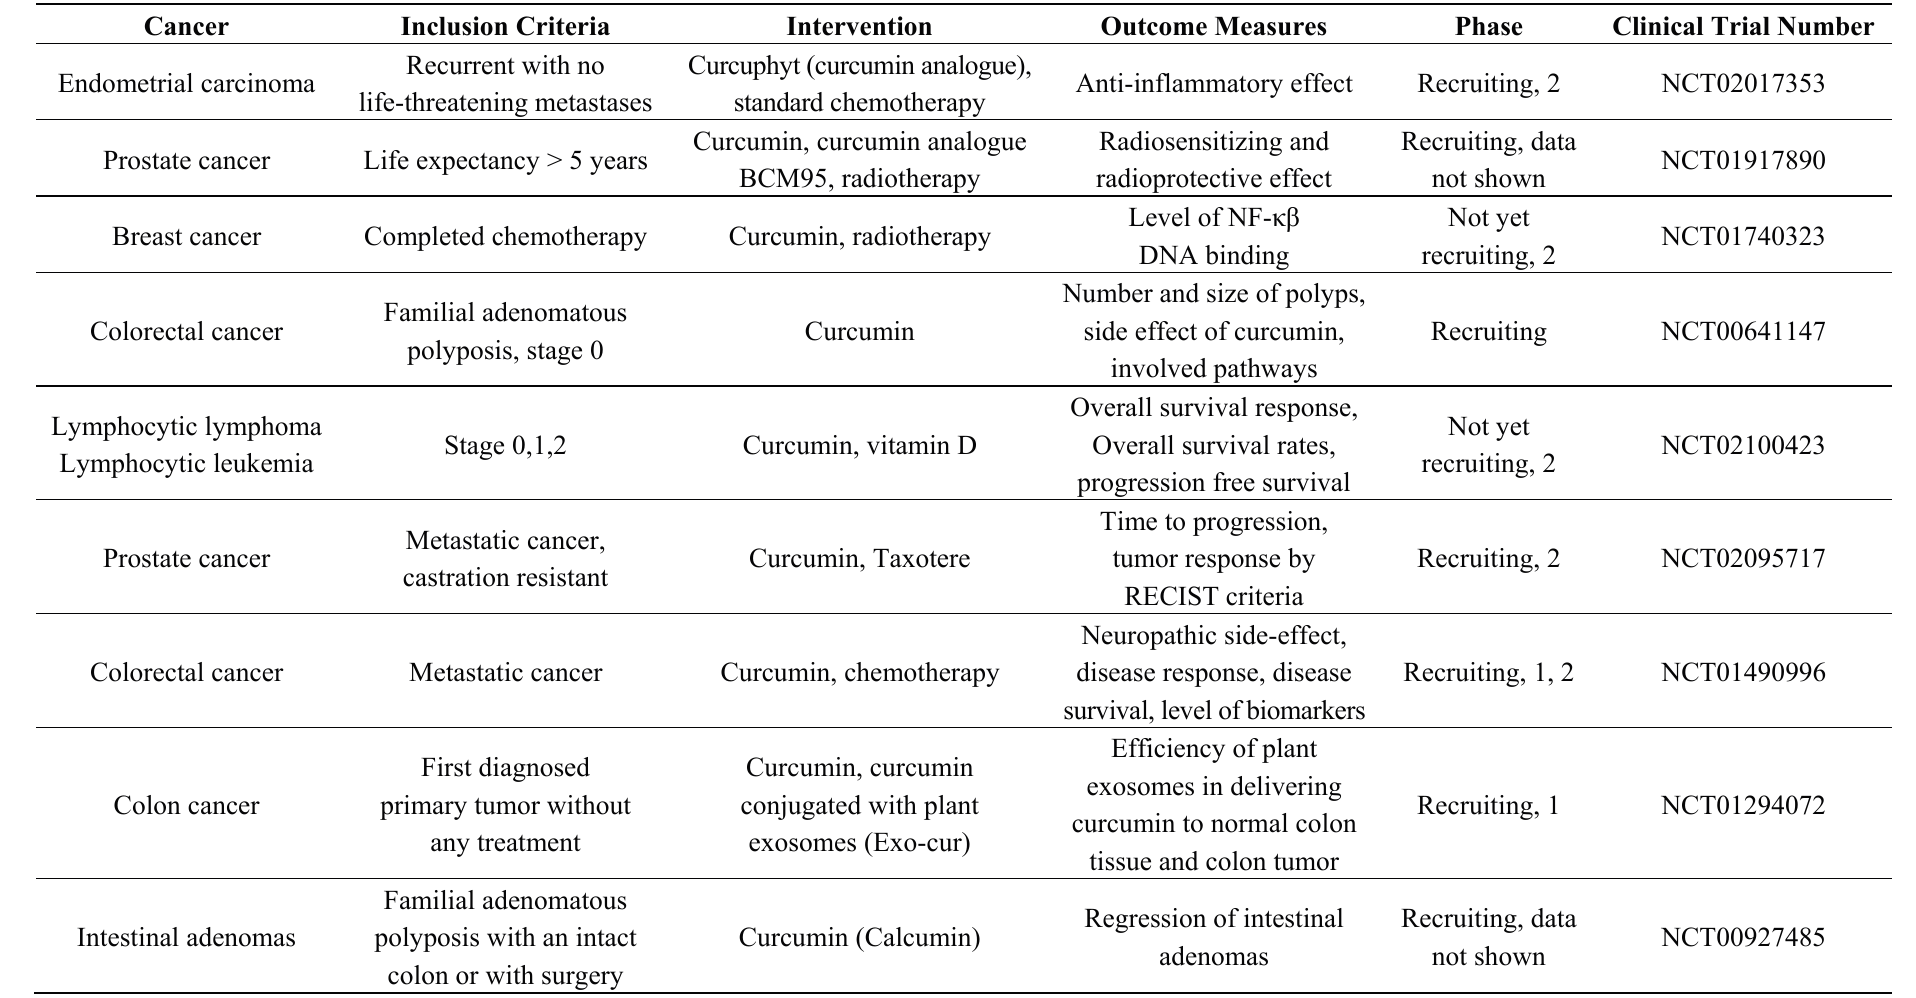
Table 2. Summary of clinical trials scheduled for curcumin assessment as an element of anticancer strategies (according to